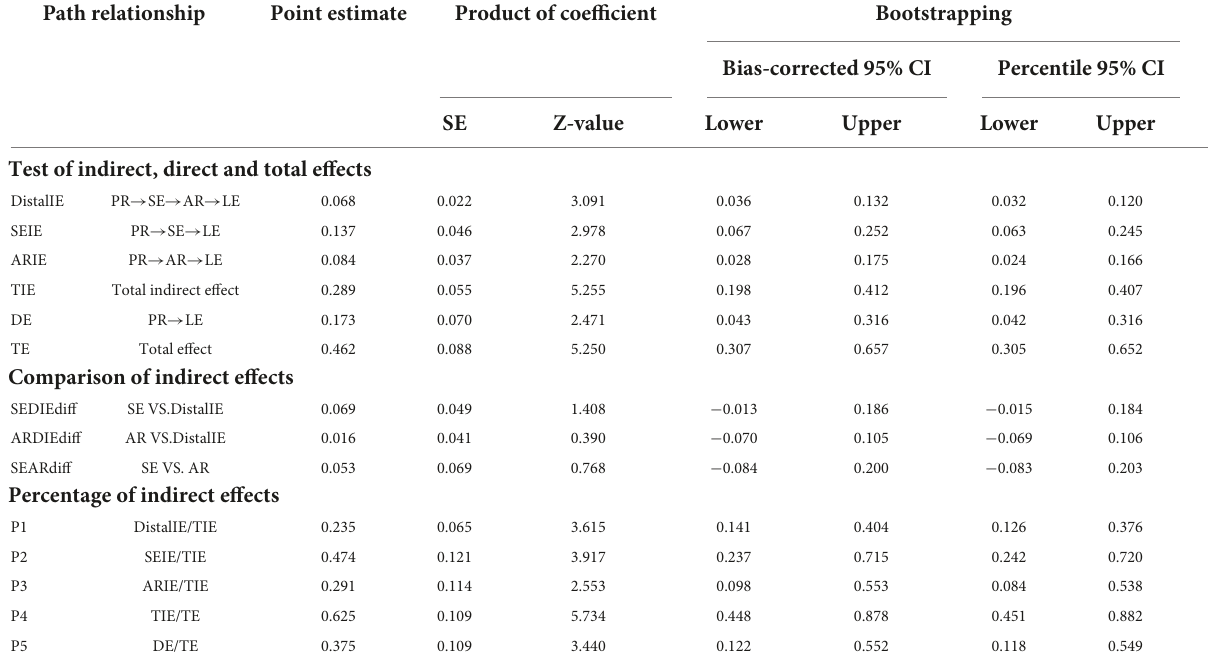
TABLE 7 Direct, indirect and total effects of the hypothesized model. Path